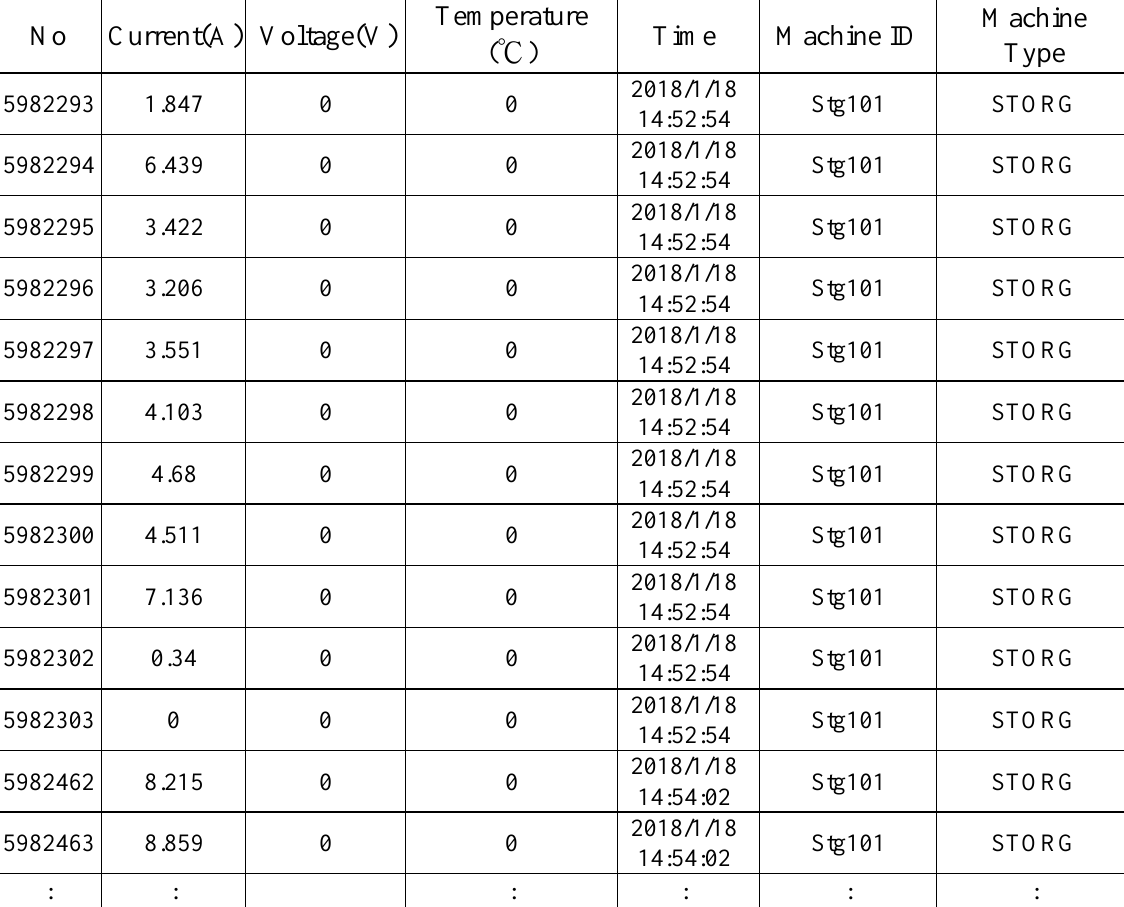
Table 1. Sensor log from the motor of vertical lift (partial